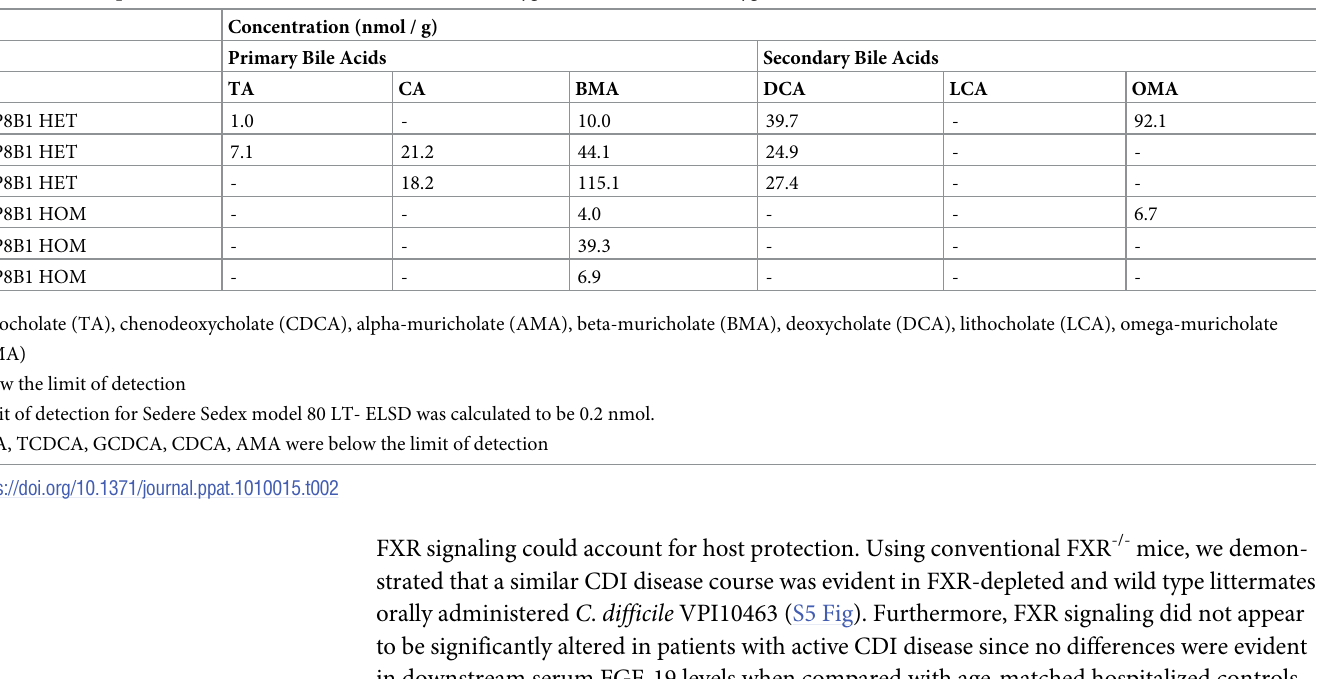
FXR signaling could account for host protection. Using conventional FXR -/- mice, we demon- strated that a similar CDI disease course was evident in FXR-depleted and wild type littermates orally administered C . difficile VPI10463 (S5 Fig). Furthermore, FXR signaling did not appear to be significantly altered in patients with active CDI disease since no differences were evident in downstream serum FGF-19 levels when compared with age-matched hospitalized controls without diarrhea (S6 Fig). Surprisingly, this finding was made despite measuring significantly altered primary and secondary bile acid profiles that are associated with CDI susceptibility in patients (S6 Fig).